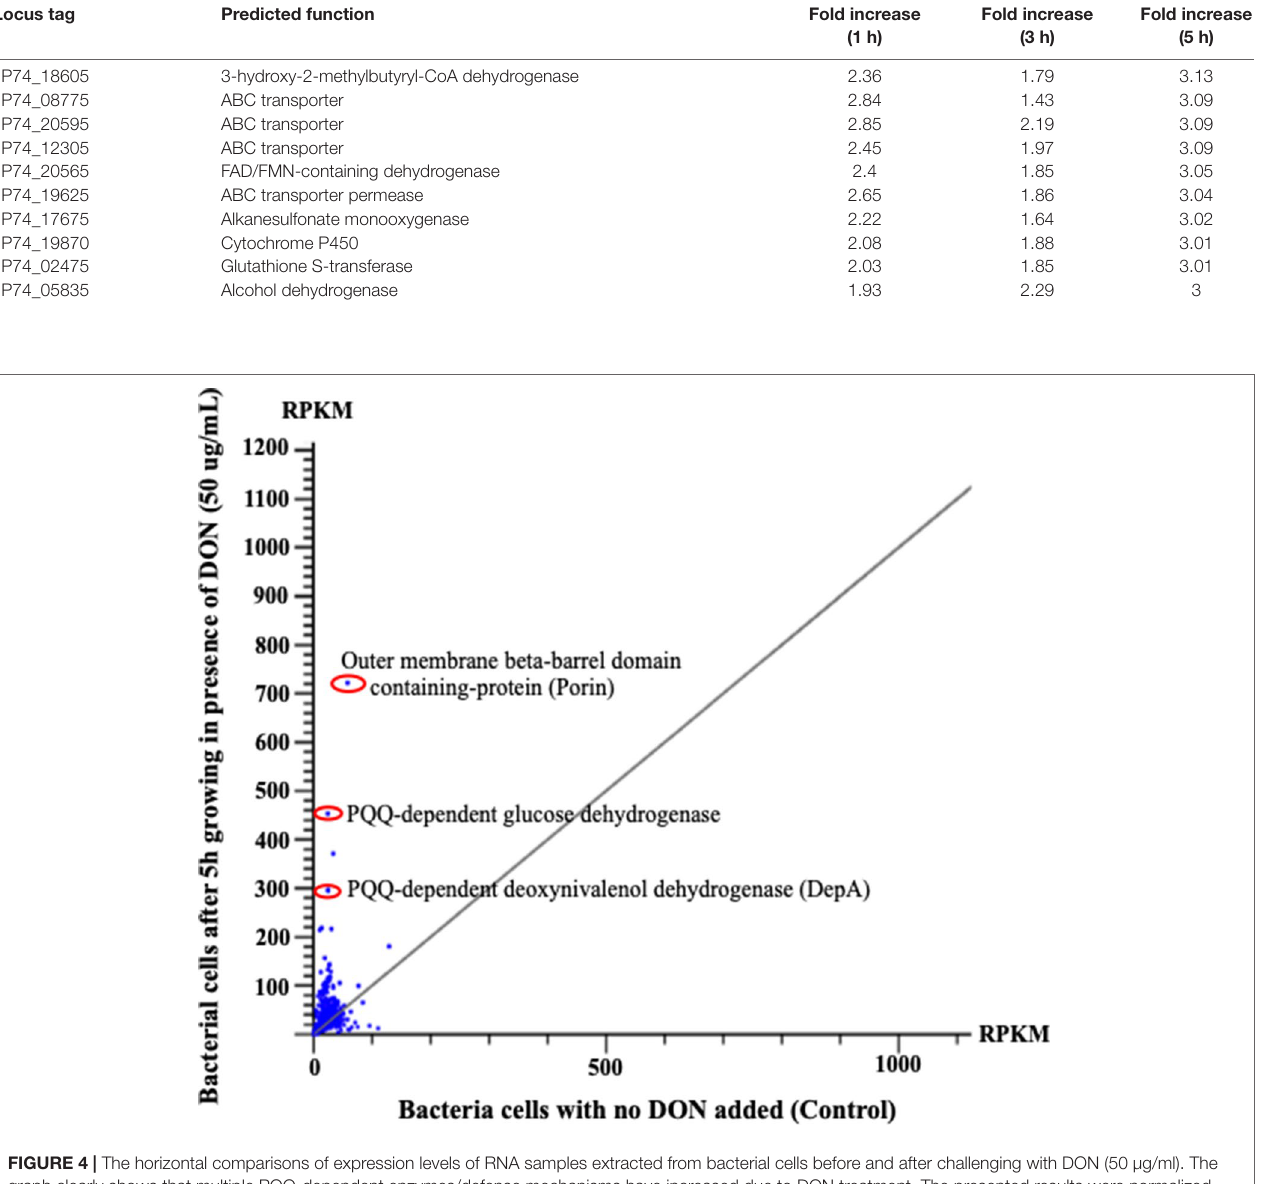
FIGURE 4 | The horizontal comparisons of expression levels of RNA samples extracted from bacterial cells before and after challenging with DON (50 µg/ml). The graph clearly shows that multiple PQQ-dependent enzymes/defense mechanisms have increased due to DON treatment. The presented results were normalized using the reads per kilobase of transcript per million mapped reads. Points/dots above the diagonal gray line indicate upregulated transcripts, while points beneath that line indicate the downregulation/suppression of the involved